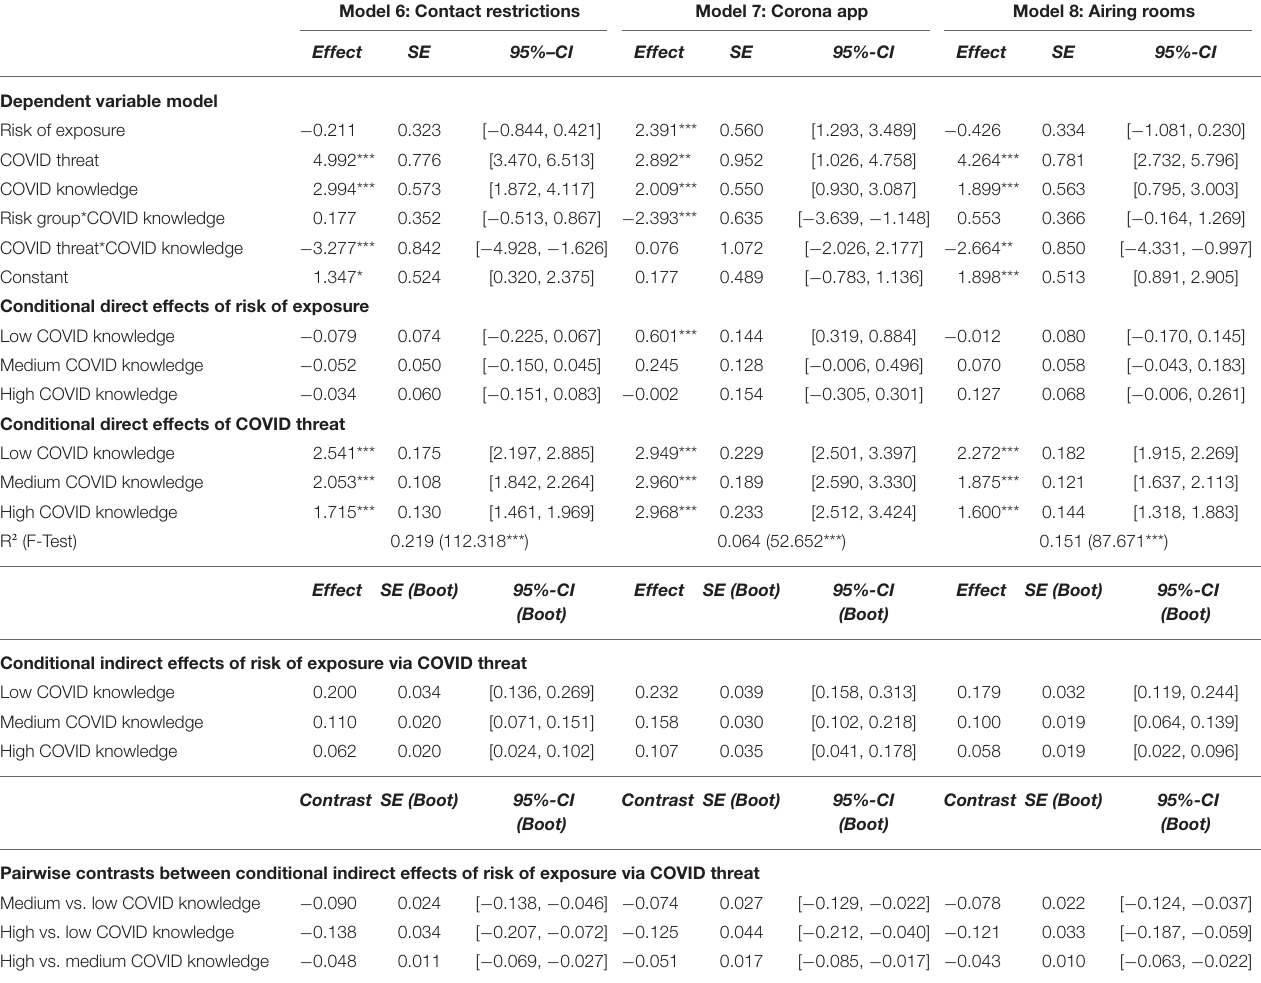
TABLE 5 | Dependent variable model of the conditional mediation model ( N = 4,096) a